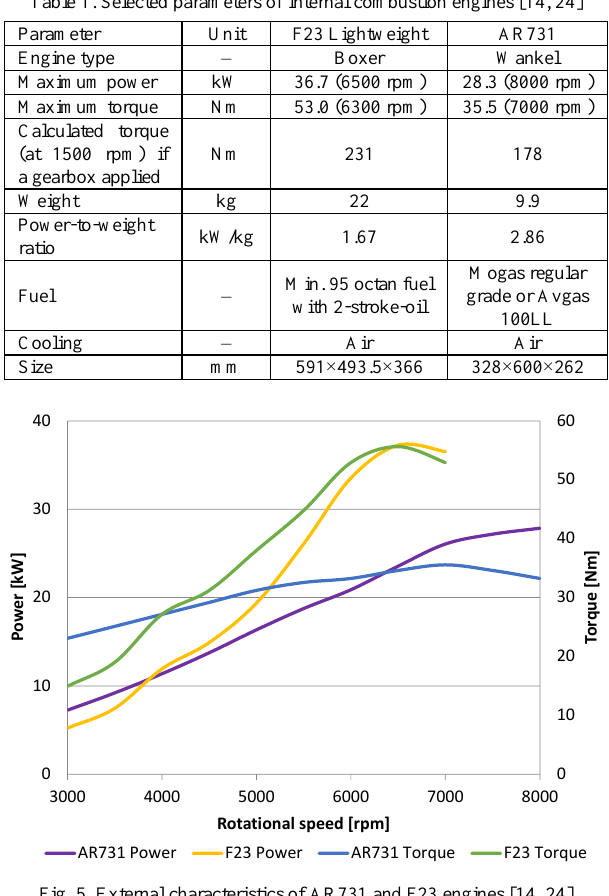
Fig. 5. External characteristics of AR731 and F23 engines [14, 24]